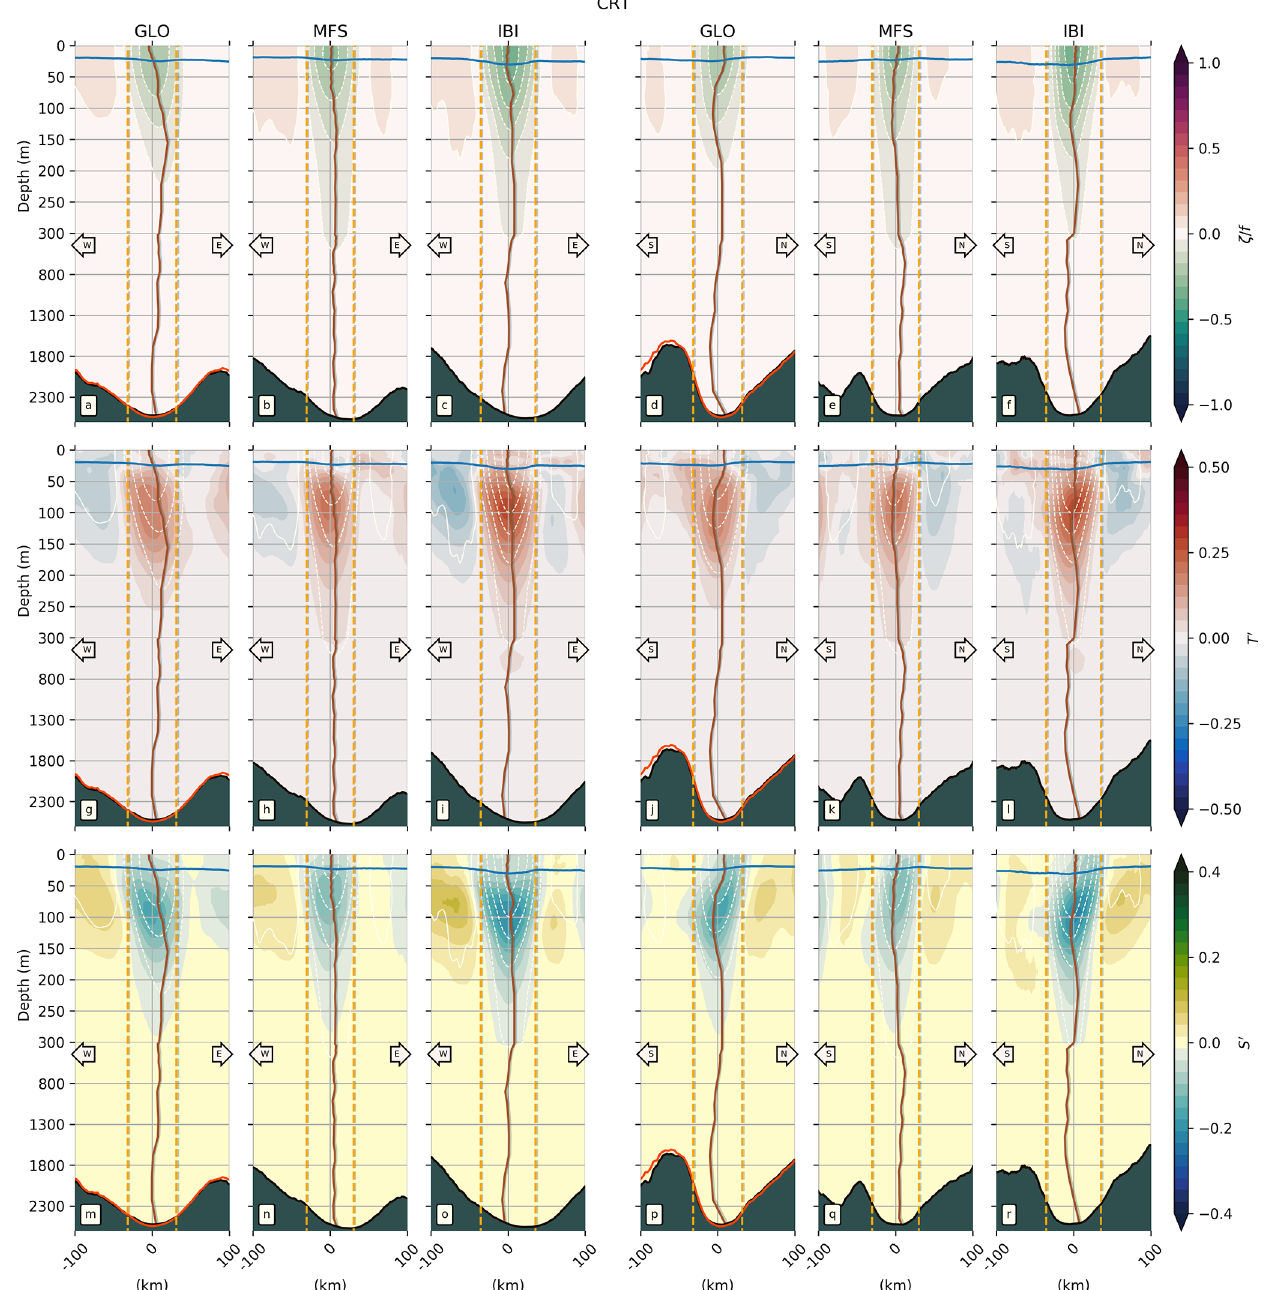
Figure 9. Same as Fig. 7 but for the Cartagena frontal